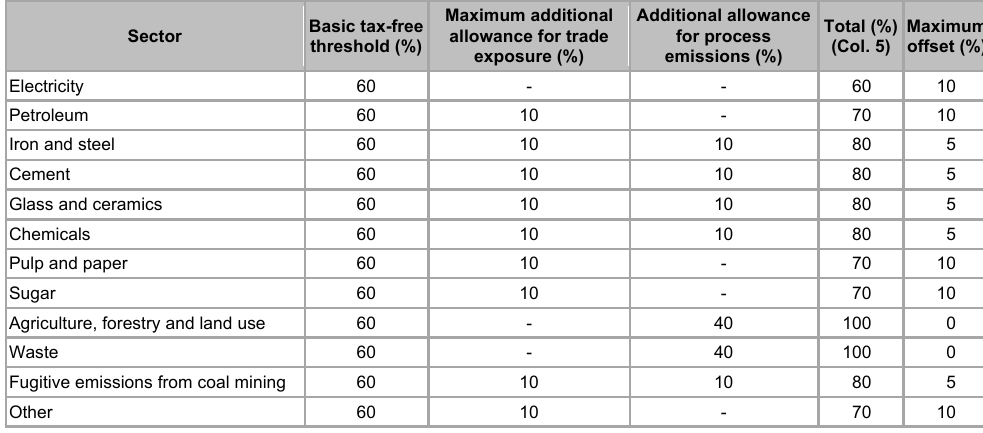
Proposed tax-free thresholds in respect of